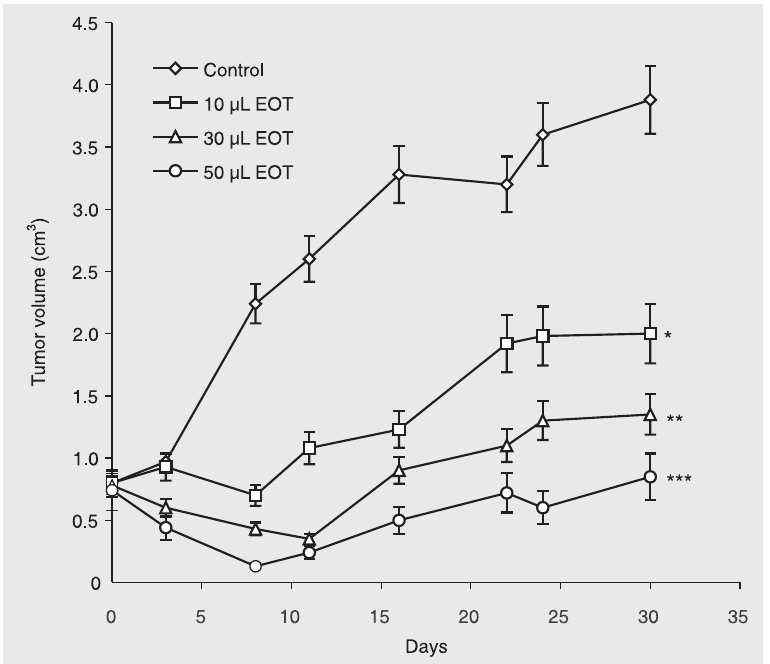
Figure 3. Effect of the essential oil of Thymus broussonettii (EOT) on the evolution of tumor volume in mice. Tumors (P815 murin mastocytoma cells) were induced in DBA-2 mice and treated using the protocol described in Material and Methods. Four groups of six mice each including controls were used. The groups were treated with PBS as negative control or with 10, 30, and 50 µL EOT per mouse. After serial injections into the tumor itself of DBA-2 mice at days 0, 3, 6, 9, 12, 15, and 18, the tumor volume of each mouse was measured with a caliper every two days as described in Material and Methods. Data are reported as the mean ± SEM of three independent experiments. NS = non-significant difference. *P < 0.05; **P < 0.005, and ***P < 0.0005 compared to PBS